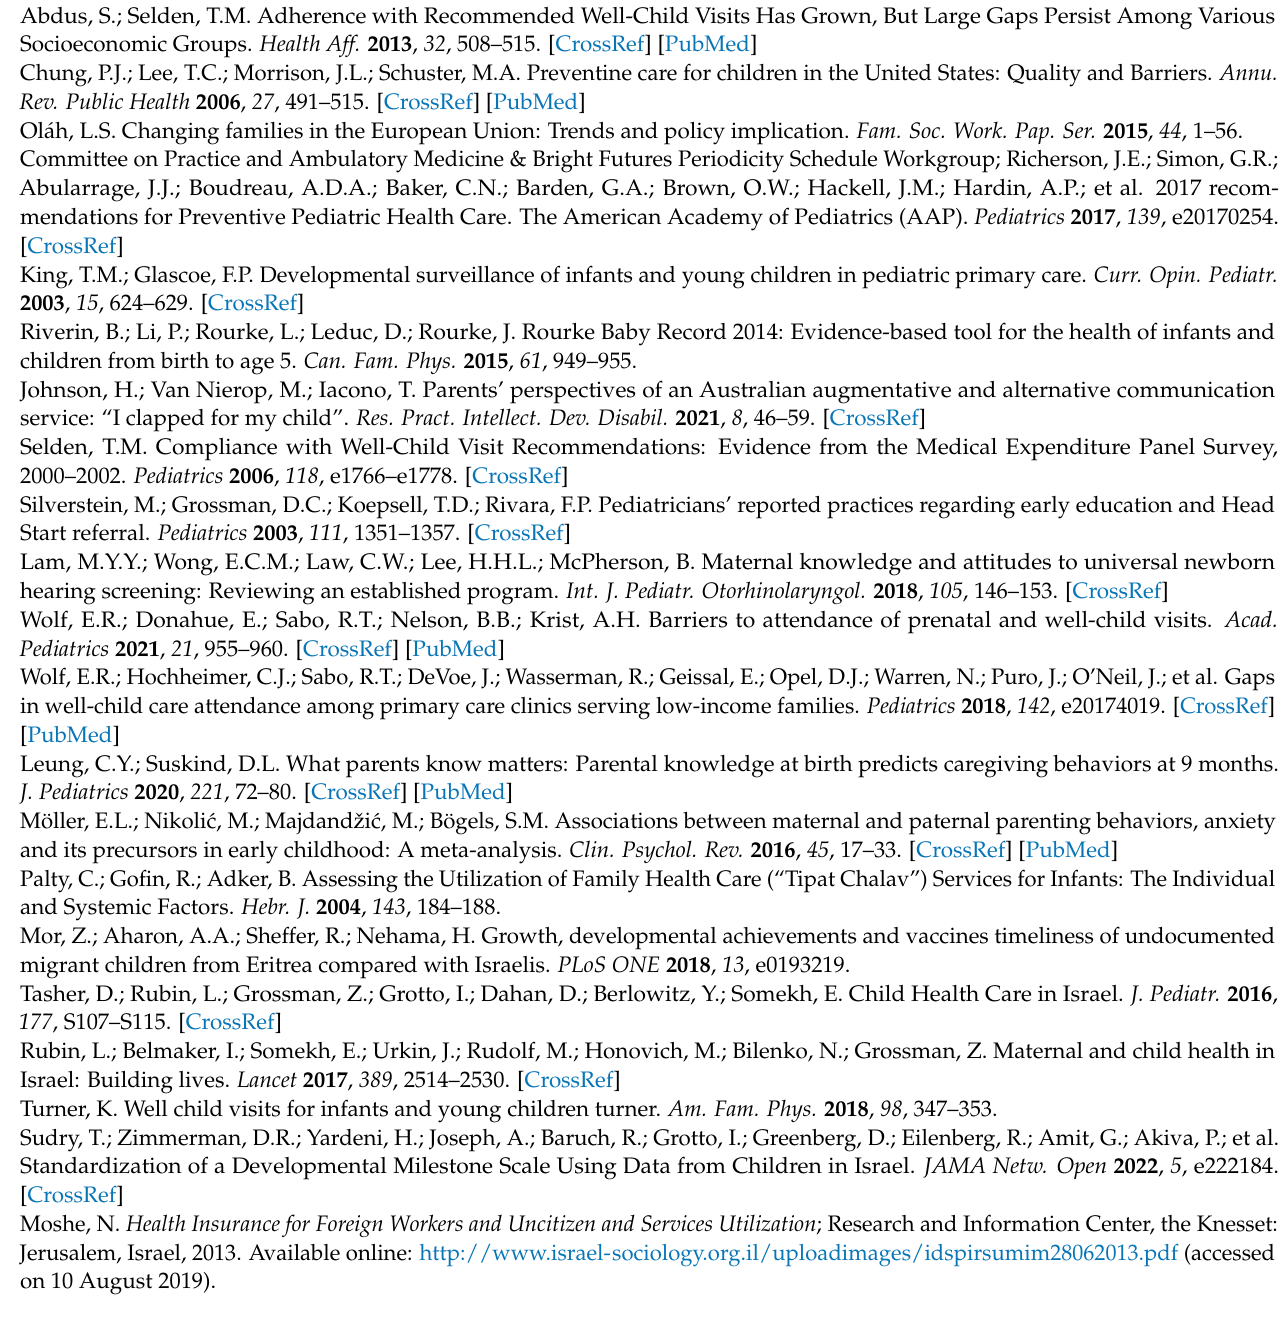
* Numbers that do not add up to 100%, meaning missing data. ** Abnormal findings, for example, prema- ture, G6PD, IUGR, VSD, PFO, torticollis, tongue-tied, coffee olla spot, systolic murmur, undescended testicles, respiratory distress, hemangiomas, skin tag, hydrocephalus, meconium amniotic